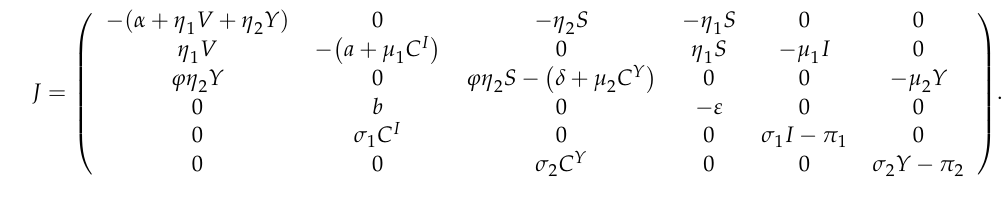
For further confirmation, we study the local stability of the system’s steady